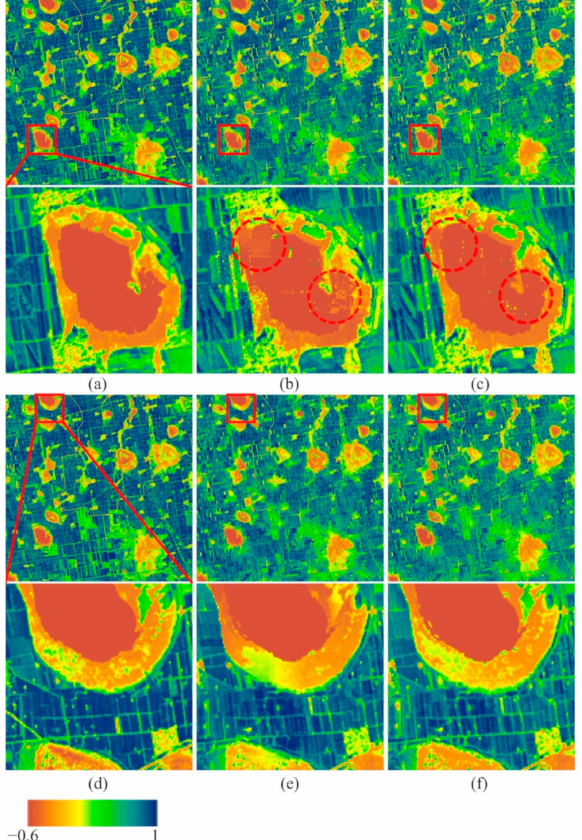
Figure 11. Landsat NDVI of western Jilin Province, China, on 2 August 2018: ( a , d ) actual images for two test areas, ( b ) image predicted by FSDAF, ( c ) image predicted by bias-corrected FSDAF, ( e ) predicted image of the STARFM, and ( f ) image predicted by the bias-corrected STARFM. The enlarged images are used for better visual